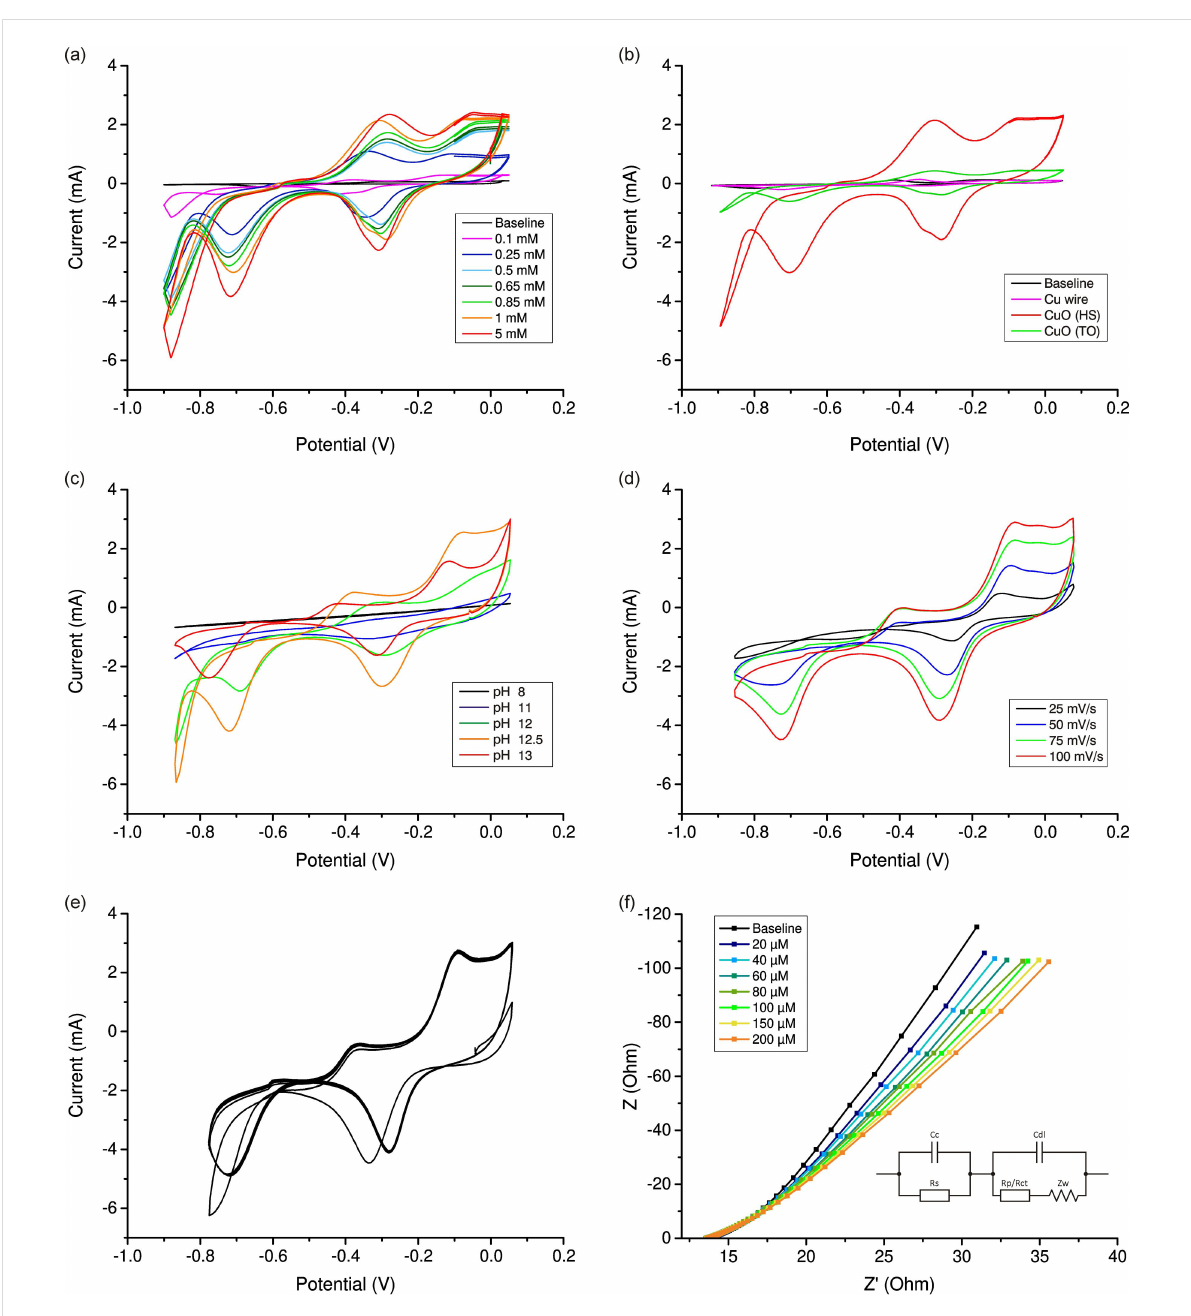
Figure 3: (a) CV results for a nanostructured CuO film in 0.1 M NaOH buffer solution (pH 12.7) and in solutions containing 0.1–5 mM H 2 O 2 . (b) Com- parison of CV results for a pure Cu wire, a CuO film obtained via thermal oxidation (TO), and a nanostructured CuO film obtained by hydrothermal synthesis (HS). Measurements were carried out in 0.1 M NaOH solution containing 5 mM H 2 O 2 . (c) Comparison of CV curves obtained at different pH values of buffer solution containing 5 mM H 2 O 2 . (d) Comparison of CV curves obtained at different scan speeds. Measurements were carried out in 0.1 M NaOH solution containing 5 mM H 2 O 2 . (e) Electrode stability study over multiple CV cycles ( n = 10). Measurements were carried out in 0.1 M NaOH solution containing 5 mM H 2 O 2 . (d) EIS analysis (frequency range from 1 Hz to 100 kHz at an applied signal voltage of about 0.3 V). Measurements were carried out in 0.1 M NaOH solution containing 0–200 μ M H 2 O 2